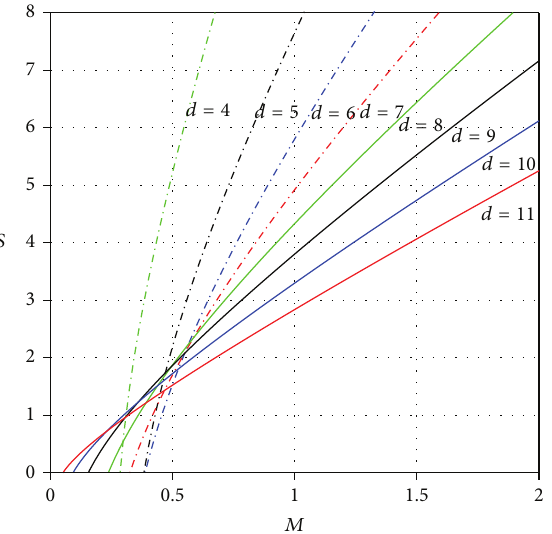
Figure 7: Black hole entropy as a function of mass for different numbers of space-time dimensions in presence of (GUP ∗∗